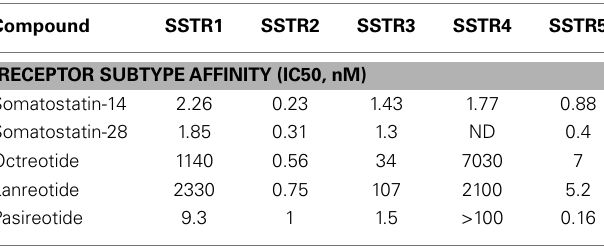
Table 3 | Somatostatin receptor subtype-binding affinity of somatostatin